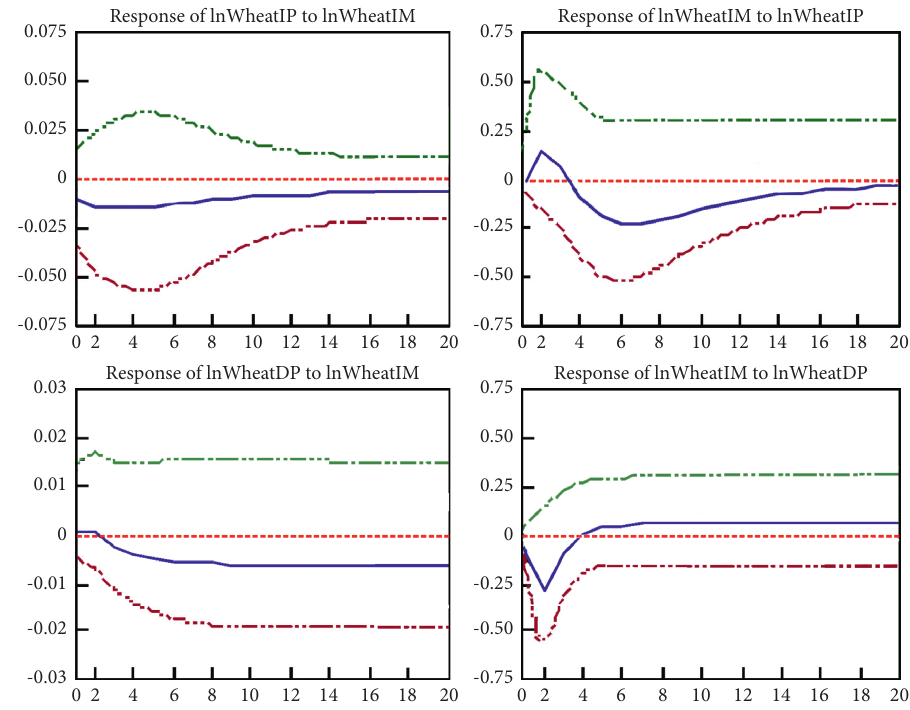
Figure 6: Pulse response analysis result for